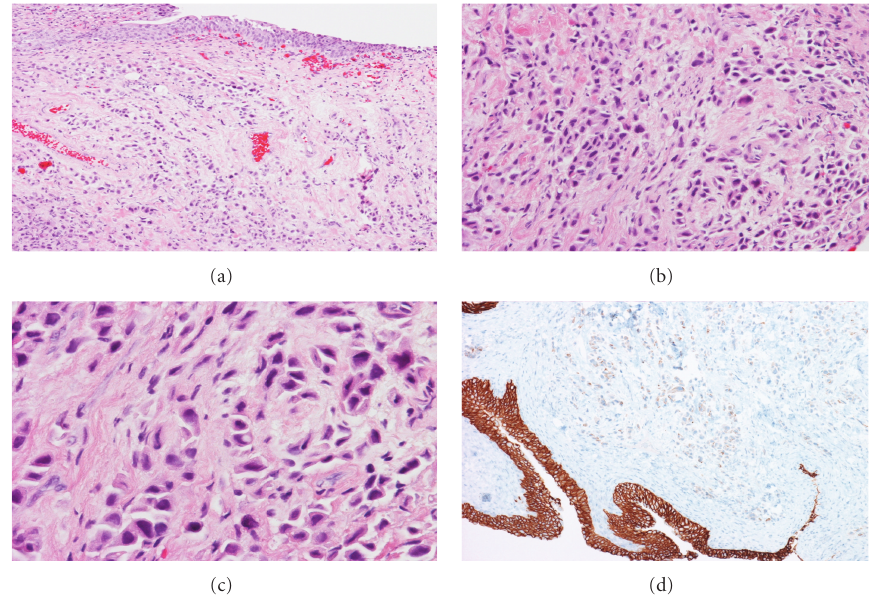
Figure 2: (a) Benign bladder mucosa (top) with di ff usely infiltrating malignant cells in the lamina propria (Hematoxylin and eosin stain × 100). (b) Discohesive and loosely clustered malignant cells in an edematous stroma (Hematoxylin and eosin stain × 200). (c) The malignant cells closely resemble plasma cells with eccentric nuclei and moderate to abundant eosinophilic cytoplasms. Prominent retraction artefacts and few cells with cytoplasmic vacuoles (center) are also seen (Hematoxylin and eosin stain × 400). (d) E-Cadhedrin staining. Normally, the positivity is strong and di ff use like in the normal urothelial mucosa in the picture (bottom). It is markedly diminished in the tumor cells (upper